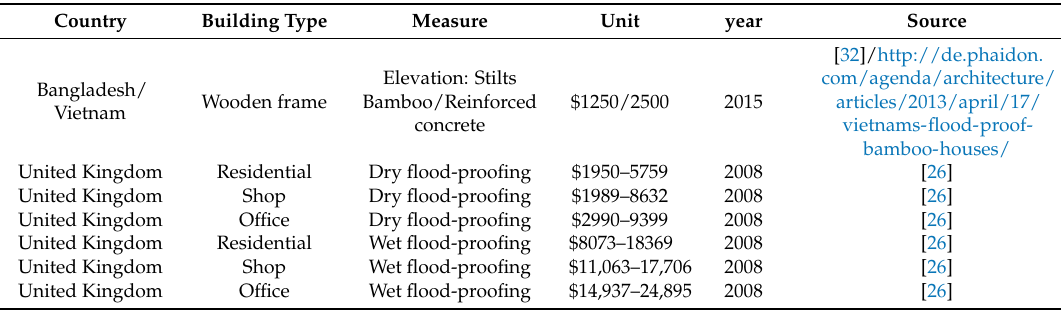
Table A1. Flood-proofing buildings.